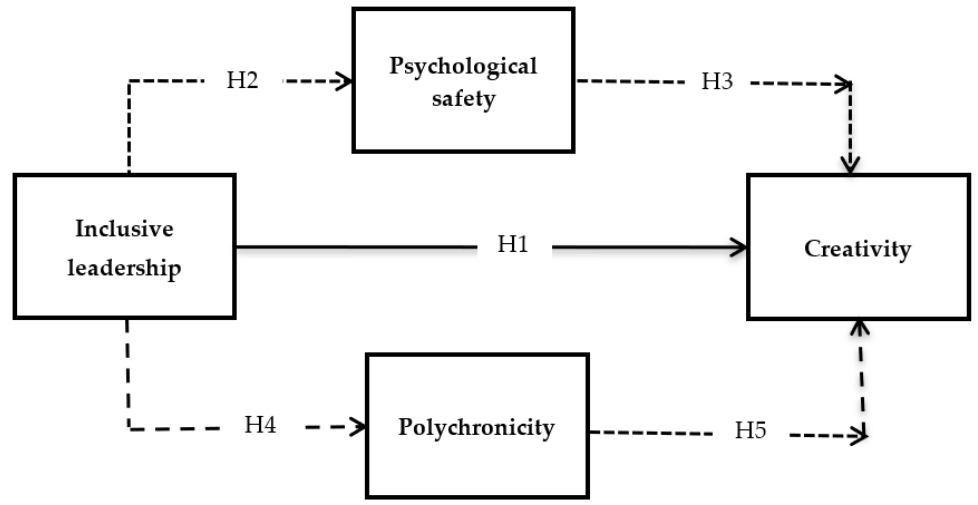
Figure 1. Hypothetical Framework.